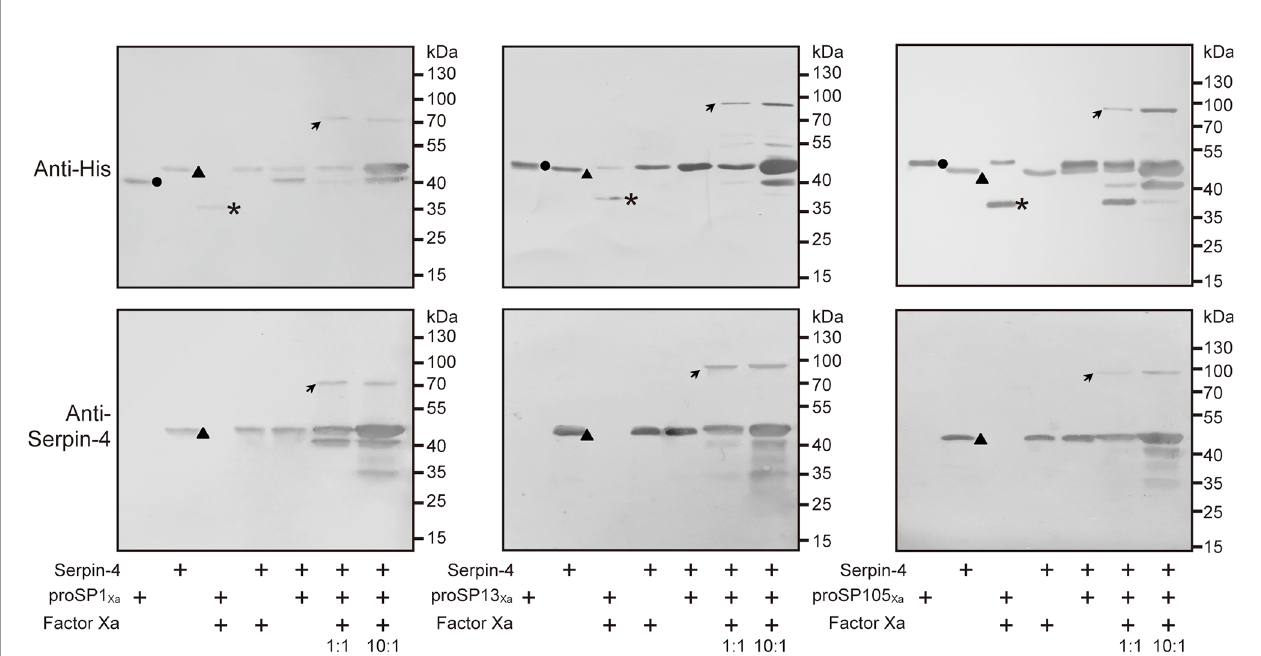
FIGURE 5 | Detection of covalent complex formation between serpin-3 and three serine proteases. 200 ng of proSP1 Xa , proSP13 Xa or proSP105 Xa was activated by Factor Xa, respectively, and incubated with puri fi ed serpin – 4 at a molar ratio of 1:1 or 10:1 (serpin – 4:SP Xa ) at 37°C for 15 min. The samples were subjected to 10% SDS – PAGE and immunoblot analysis using antiserum against His ( upper panel ) or O. furnacalis serpin – 4 ( lower panel ) as primary antibodies. The sizes and positions of the molecular mass standards were indicated to the right of each blot. Circles, proSP Xa ; triangles, serpin – 4; asterisks, catalytic domain of proSP Xa ; arrows, serpin – 4/SP